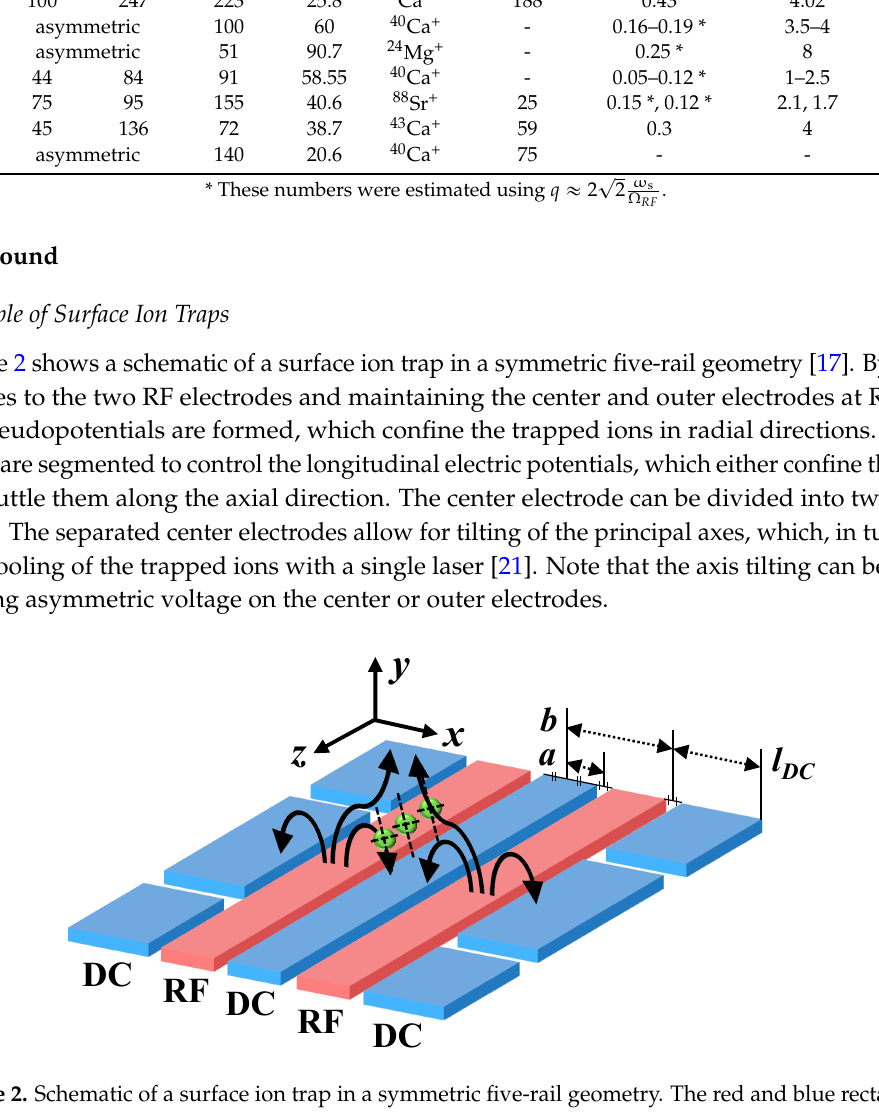
Table 1. Electrode dimensions and specifications of surface ion traps.